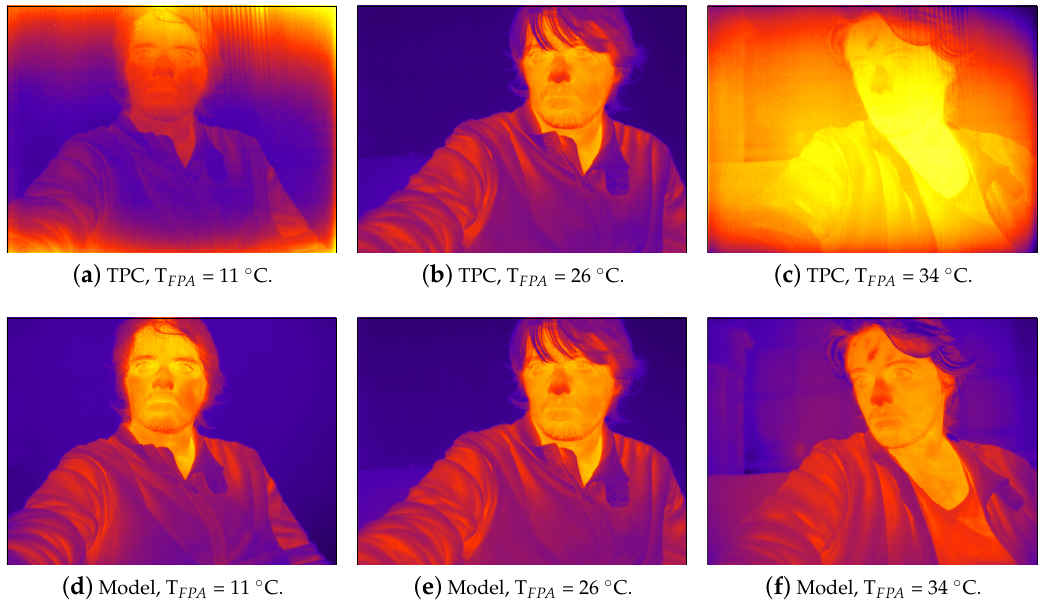
Figure 5. Video captures from the FLIR core at different focal plane array (FPA) temperatures. ( top ) Using two-point calibration (TPC); ( bottom ) Using our